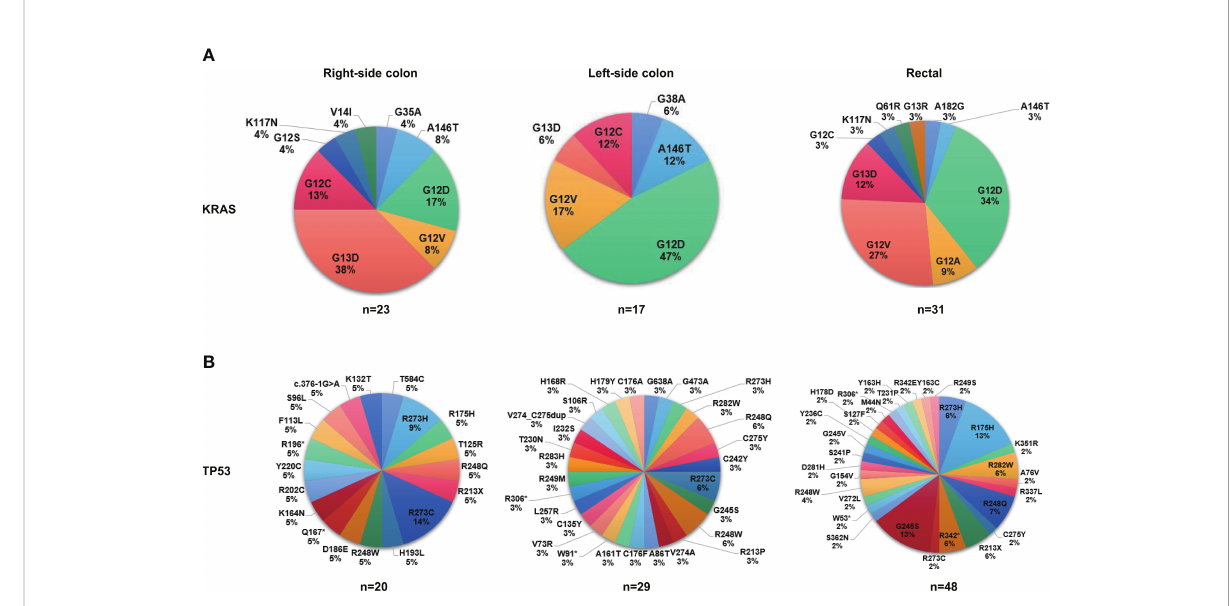
FIGURE 5 The proportions of mutation sites of KRAS and TP53 in different tumor anatomic locations. (A) The proportions of mutation sites of KRAS in different tumor anatomic locations (right-sided colon, N=31; left-sided colon, N=36; rectal, N=66). (B) The proportions of mutation sites of TP53 in different tumor anatomic locations (right-sided colon, N=31; left-sided colon, N=36; rectal,